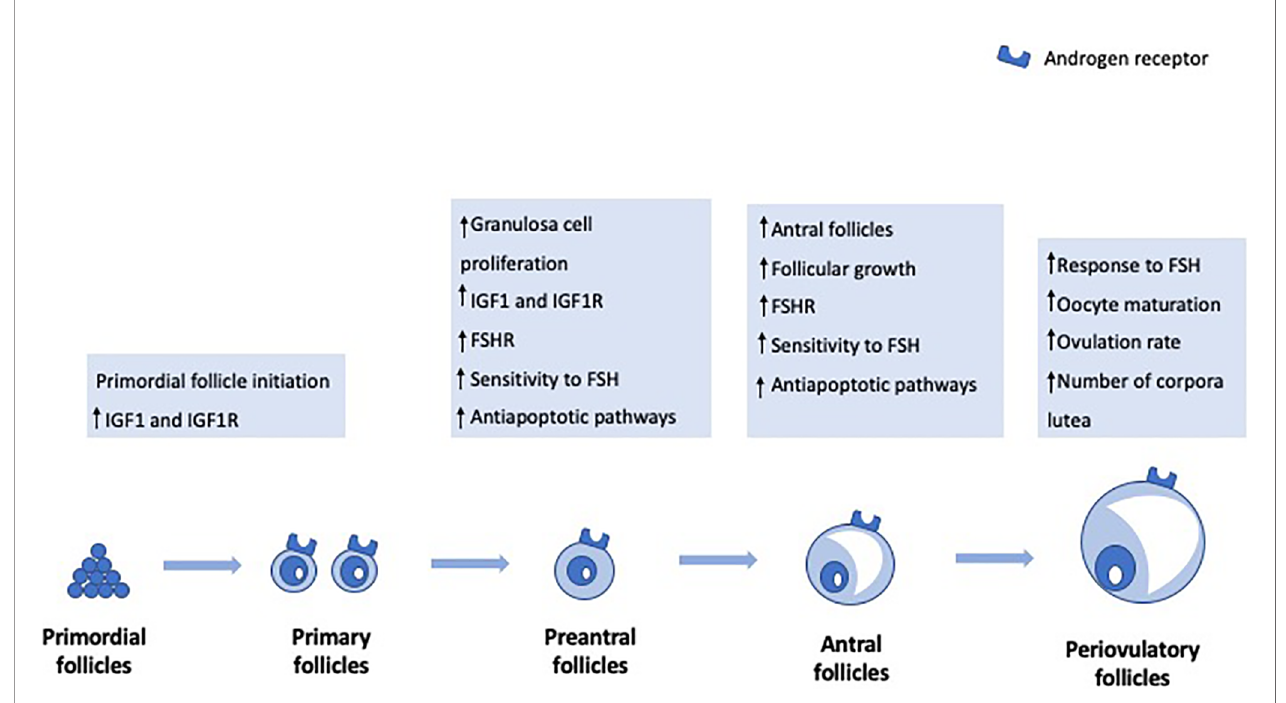
FIGURE 1 | Androgen effects on